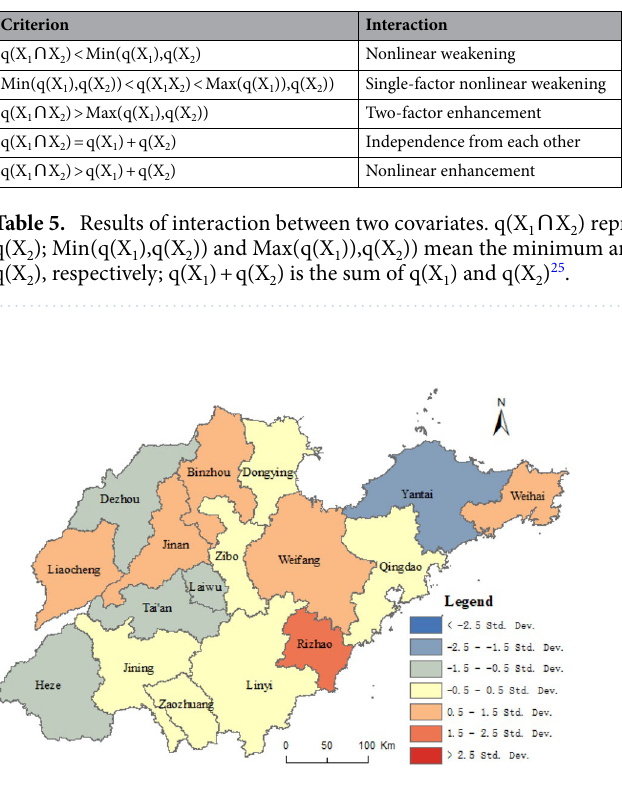
Figure 7. The results of standard error. This figure was created with ArcGIS 10.5 (URL: http:// www. esri. com/).